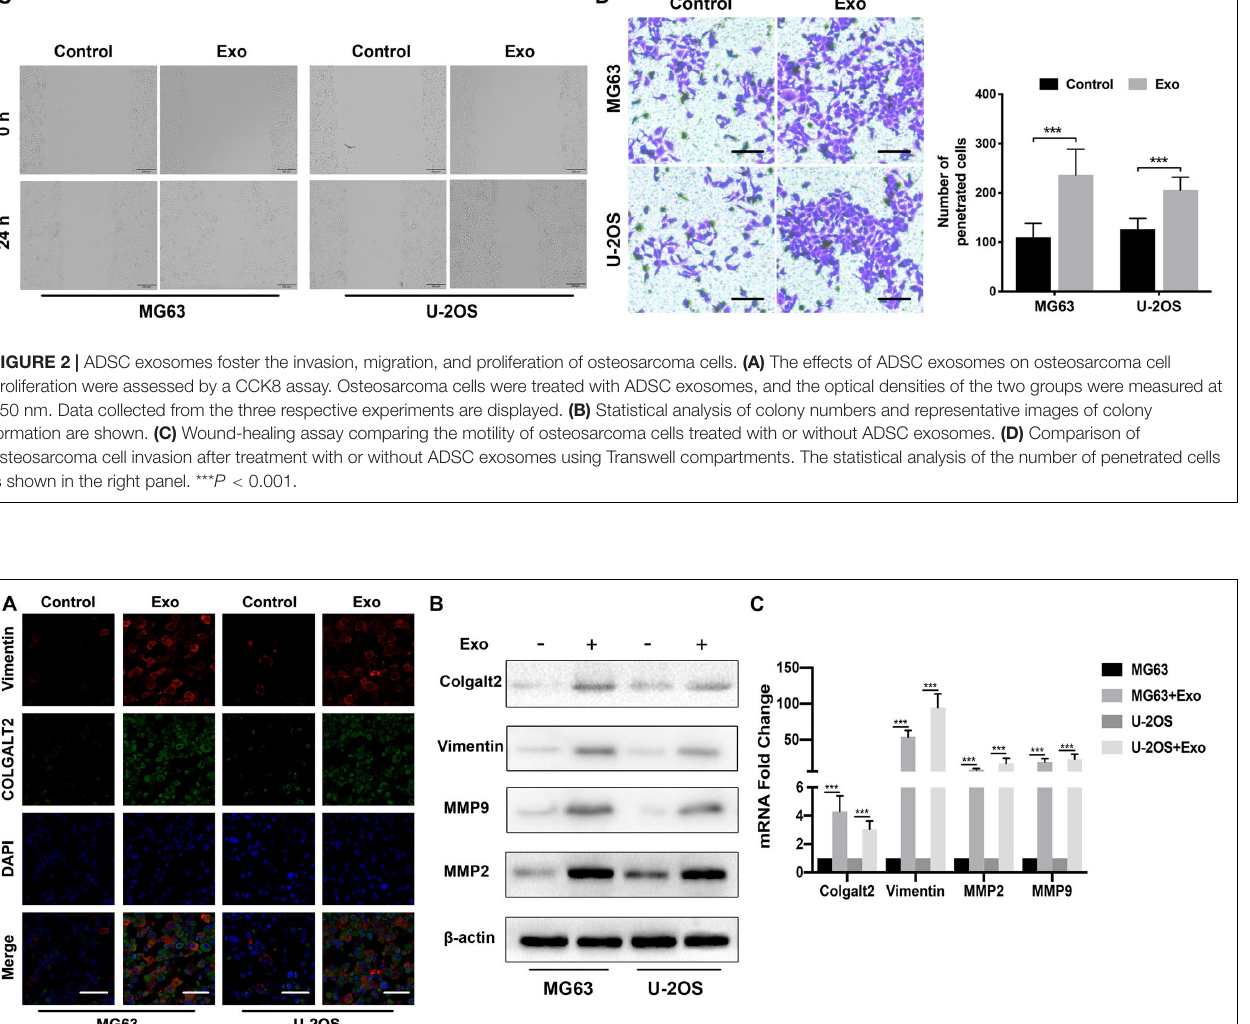
FIGURE 3 | ADSC exosomes induce COLGALT2 upregulation in osteosarcoma cells, accompanied by increased vimentin and MMP2/9 expression. (A) Representative IF images of vimentin and COLGALT2 in osteosarcoma cells treated with or without ADSC exosomes. Scale bar = 25 µ m. (B) Western blotting shows that in osteosarcoma cells, ADSC exosome treatment upregulated the expression of COLGALT2, vimentin, MMP9 and MMP2. (C) Real-time PCR displays the relative mRNA expression levels of COLGALT2, vimentin, MMP9 and MMP2 in osteosarcoma cells treated with or without ADSC exosomes. *** P < 0.001.